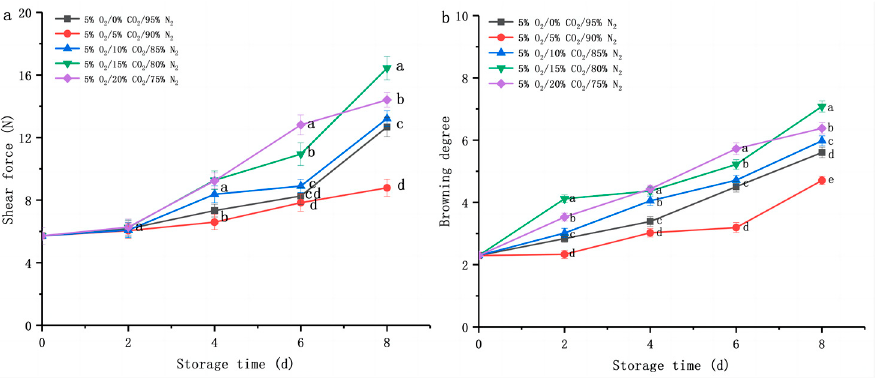
Figure 3. Effect of CO 2 concentration (%) with 5% O 2 on shear force ( a ), and browning degree ( b ) of fresh-cut Dictyophora rubrovolvata . Differences at p < 0.05 are indicated by different letters and data are expressed as the mean ± SD.